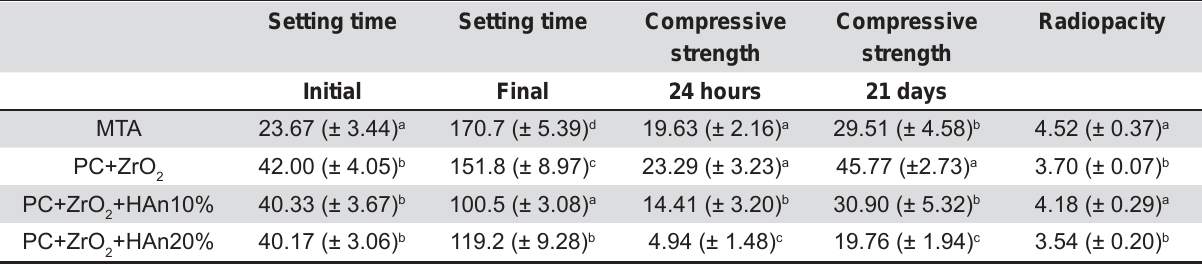
Table 1- (cid:3)(cid:48)(cid:72)(cid:68)(cid:81)(cid:3)(cid:89)(cid:68)(cid:79)(cid:88)(cid:72)(cid:86)(cid:3)(cid:68)(cid:81)(cid:71)(cid:3)(cid:86)(cid:87)(cid:68)(cid:81)(cid:71)(cid:68)(cid:85)(cid:71)(cid:3)(cid:71)(cid:72)(cid:89)(cid:76)(cid:68)(cid:87)(cid:76)(cid:82)(cid:81)(cid:3)(cid:73)(cid:82)(cid:85)(cid:3)(cid:76)(cid:81)(cid:76)(cid:87)(cid:76)(cid:68)(cid:79)(cid:3)(cid:68)(cid:81)(cid:71)(cid:3)(cid:191)(cid:81)(cid:68)(cid:79)(cid:3)(cid:86)(cid:72)(cid:87)(cid:87)(cid:76)(cid:81)(cid:74)(cid:3)(cid:87)(cid:76)(cid:80)(cid:72)(cid:3)(cid:11)(cid:80)(cid:76)(cid:81)(cid:88)(cid:87)(cid:72)(cid:86)(cid:12)(cid:15)(cid:3)(cid:70)(cid:82)(cid:80)(cid:83)(cid:85)(cid:72)(cid:86)(cid:86)(cid:76)(cid:89)(cid:72)(cid:3)(cid:86)(cid:87)(cid:85)(cid:72)(cid:81)(cid:74)(cid:87)(cid:75)(cid:3)(cid:11)(cid:48)(cid:51)(cid:68)(cid:12)(cid:3)(cid:68)(cid:73)(cid:87)(cid:72)(cid:85)(cid:3) 24 hours and 21 days and radiopacity (mmAl)